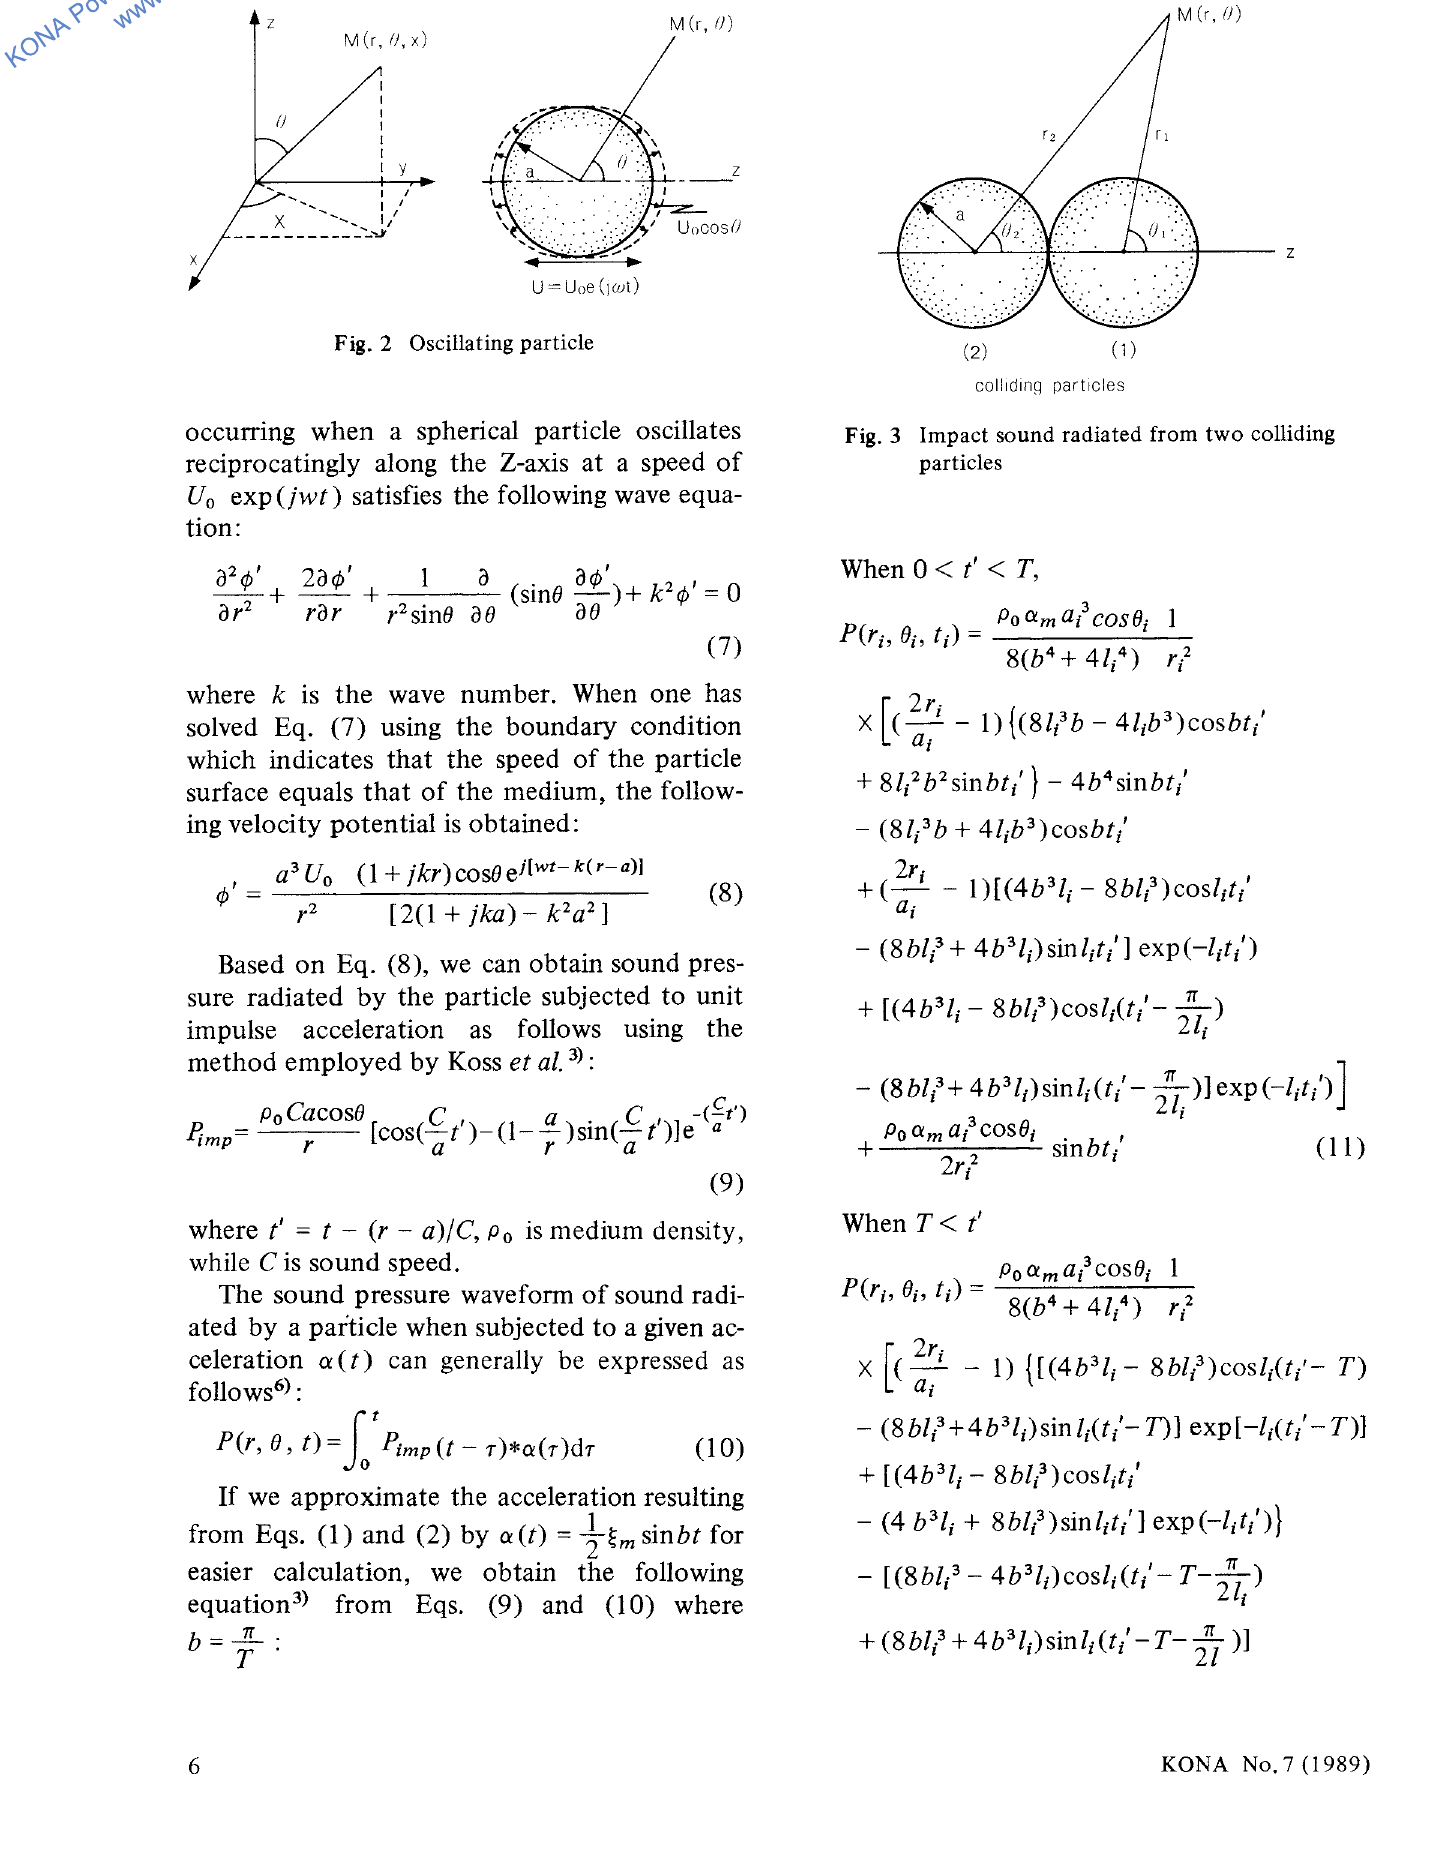
Fig. 3 Impact sound radiated from two colliding